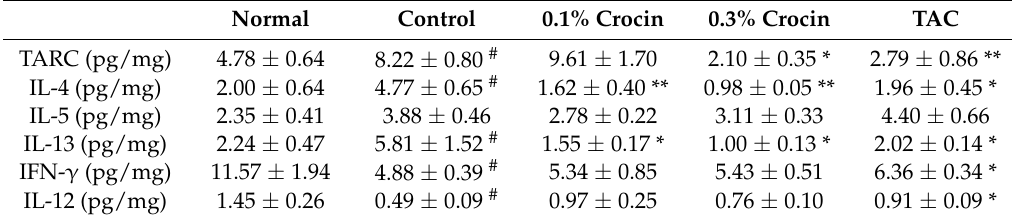
Table 1. Protein contents of chemokine and cytokines in the dorsal skin lesions.